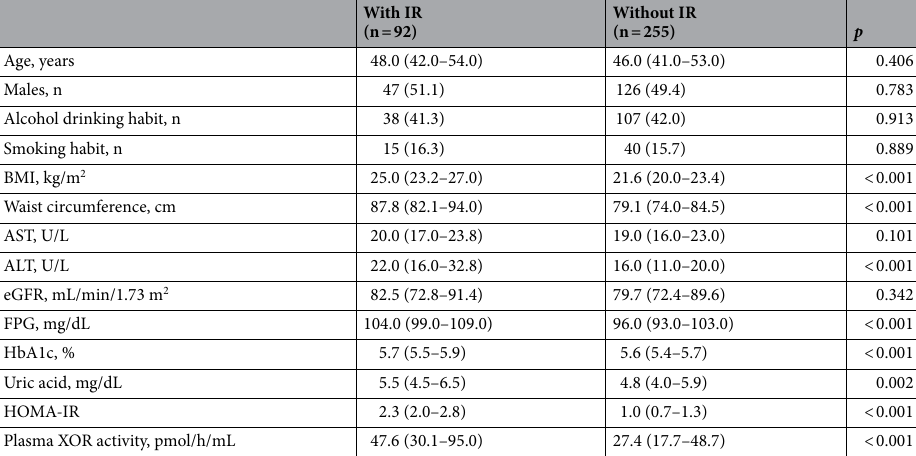
Table 2. Comparison of clinical characteristics between subjects with and without IR at baseline. Values are expressed as median (interquartile range) or number (%). p Values are shown for comparisons between subjects with (HOMA-IR ≥ 1.7) and without (HOMA-IR < 1.7) IR. IR insulin resistance, BMI body mass index, AST aspartate aminotransferase, ALT alanine aminotransferase, eGFR estimated glomerular filtration rate,